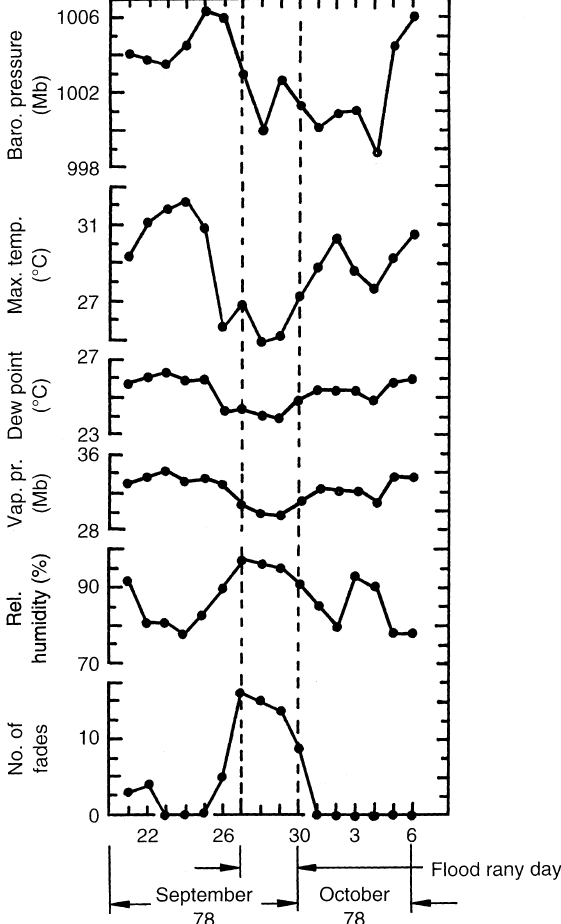
Fig. 6. Plot of various meteorological parameters like relative humidity (%), vapour pressure (mb), due point ( (cid:176) C), maximum temperature ( (cid:176) C), barrometric pressure (mb) against number of fades showing a simultaneous fluctuation of all the parameters during the flood rainy days